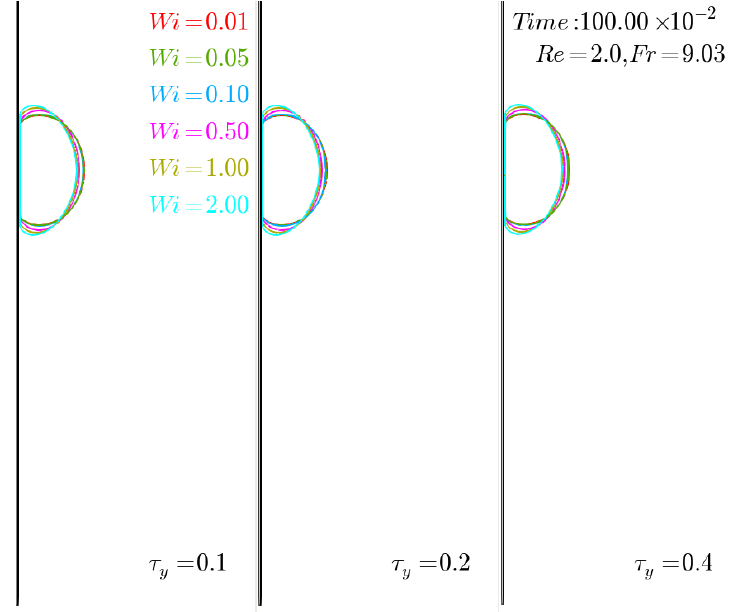
Figure 12. Collision of drops on a vertical wall for fixed values of the Reynolds, Re = 2, and Froude numbers, Fr = 9.03 and the following values of the Weissenberg number, Wi = { 0.01;0.1;0.5;1;2 } . ( left column ) τ y = 0.1; ( right column ) τ y = 0.2; ( right column ) τ y = 0.4. Dimensionless time, t = 1.